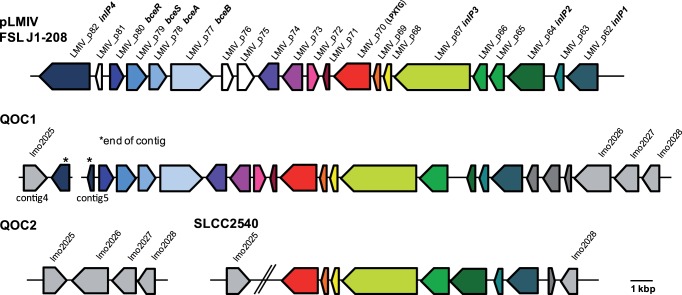
Genomic organization of the hypervariable hotspot 9 region in L. monocytogenes genomes harbouring homologues to proteins from plasmid pLMIV of L. monocytogenes FSL J1–208.Homologous proteins are shown as the same color. pLMIV and L. monocytogenes EGDe locus_tags are indicated.